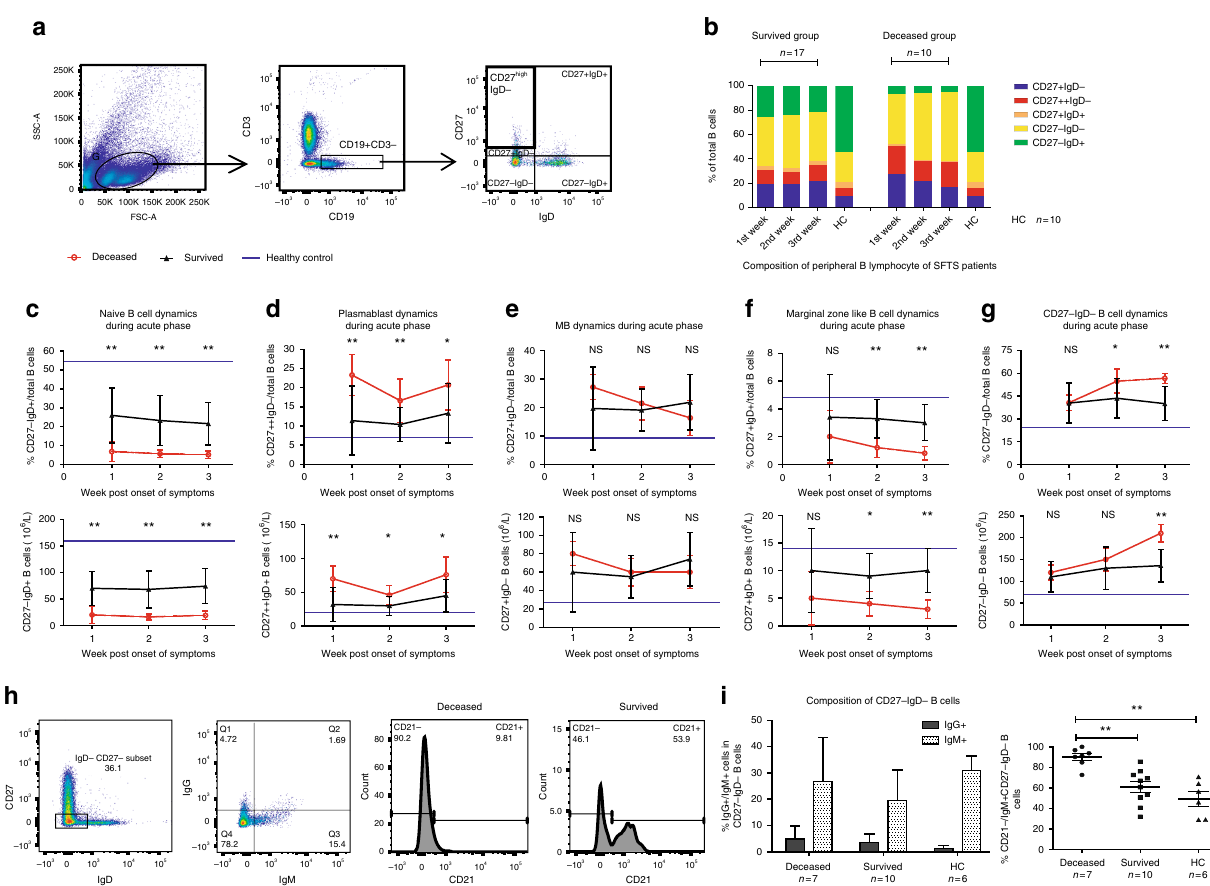
Fig. 3 Kinetics of peripheral B-cell subsets during acute phase of SFTS. a FACS gating strategy to de fi ne B-cell subsets by CD27 and IgD. b Schematic presentation of the relative composition of B-cell subsets in total peripheral B cells in the 3-week period post symptom onset. IgD − CD27 + , IgD − CD27 ++ , IgD + CD27 + , IgD − CD27 − and IgD + CD27 − represent memory, plasmablast, marginal zone-like, double negative and naive B-cell subsets respectively. HC = healthy control. c – g Kinetics of the proportion (upper) and numbers (lower) of B-cell subsets in total B cells and comparison of each subset between survived and deceased patients. Black triangles, red circles and blue horizontal lines represent means of survived, deceased and HC group, respectively. Statistic analysis was conducted between the survived and deceased groups. h FACS gating strategy de fi ning IgG, IgM and CD21 expression in CD27 − IgD − subset of B cells. i Expression of IgG and IgM in CD27 − IgD − B cells (left) and the ratio of CD21 − subset among IgM-producing CD27 − IgD − B cells (right), shown as means ± SD. * p < 0.05, ** p < 0.005. Error bar represents the standard deviation; NS = no signi fi